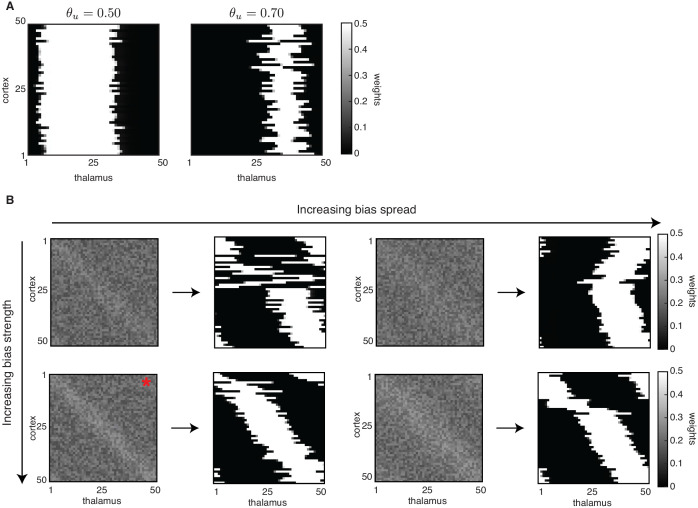
Effect of initial bias on receptive field refinements and topography. (A) Without the weak bias along the diagonal, selectivity is achieved so that each cortical cell is connected to a few thalamic inputs; however, the same set of input neurons innervates all cortical neurons. Receptive fields were generated with the Hebbian covariance rule, but similar outcomes are obtained with the BCM rule. (B) Each pair of plots shows the initial biased connectivity (left) and the final outcome of the simulation (right) for one combination of bias spread and bias strength. Top: Weaker bias strength (relative to the nominal one used in the paper simulations) with increasing spread. Bottom: Nominal bias strength with increasing spread. Initial conditions used in the paper correspond to the bottom left panel (marked with a red asterisk). Simulations of the Hebbian learning rule with an input threshold θu=0.6 and only L-events. We show bias strength s=0.025, 0.05 and bias spread δs=4, 8.